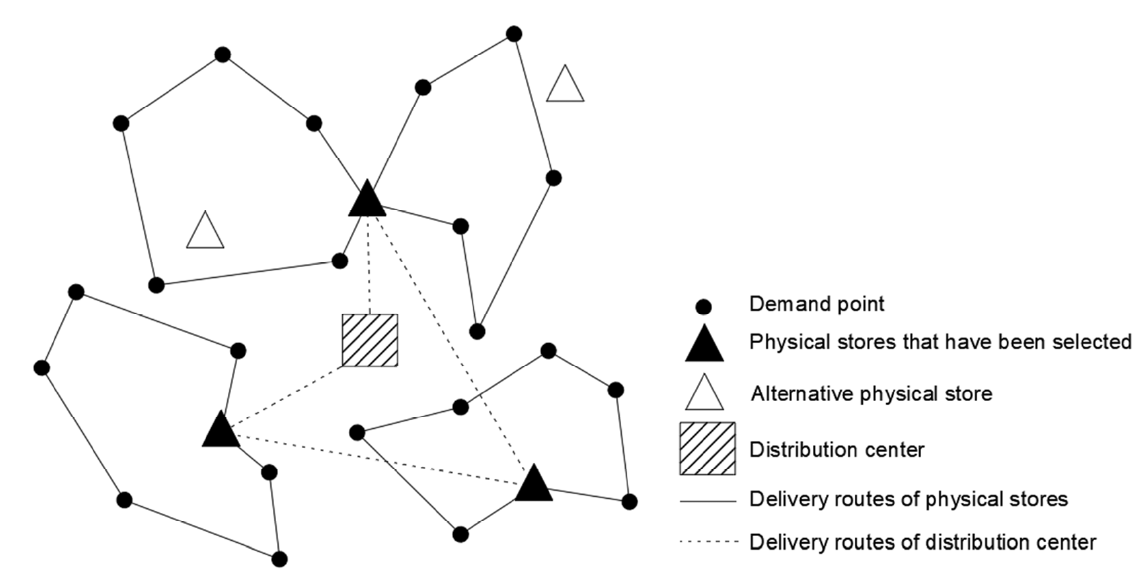
Figure 1. Schematic diagram of logistics system.